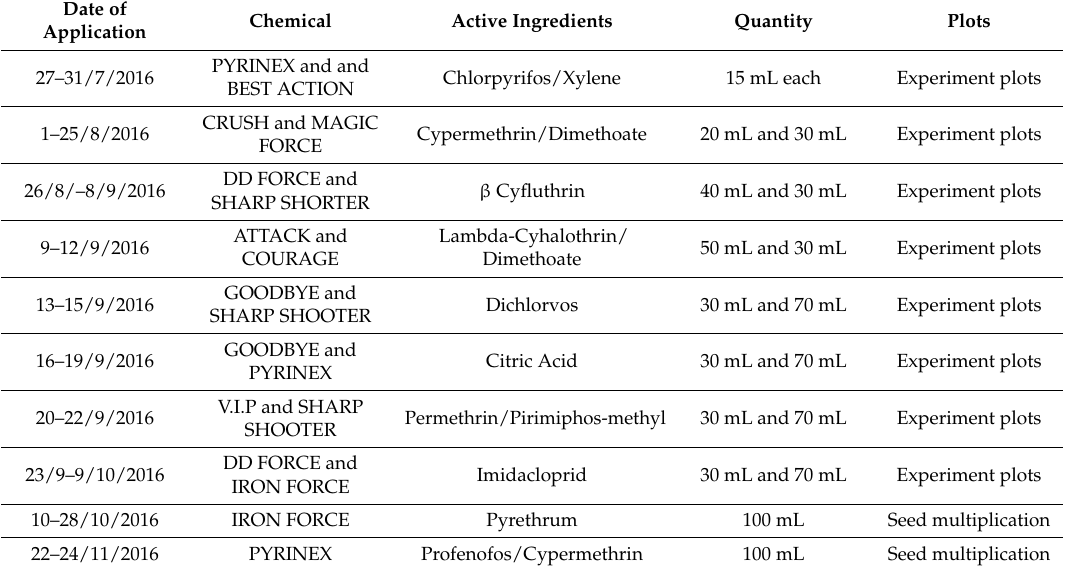
Table 1. List of chemicals, their active ingredients, and quantity applied in